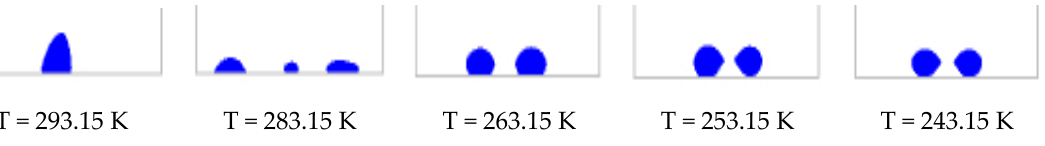
T = 293.15 K T = 283.15 K T = 263.15 K T = 253.15 K T = 243.15 K Figure 15. Water droplets at 0.14 s. Grey line is the solid bottom; blue is water droplet.